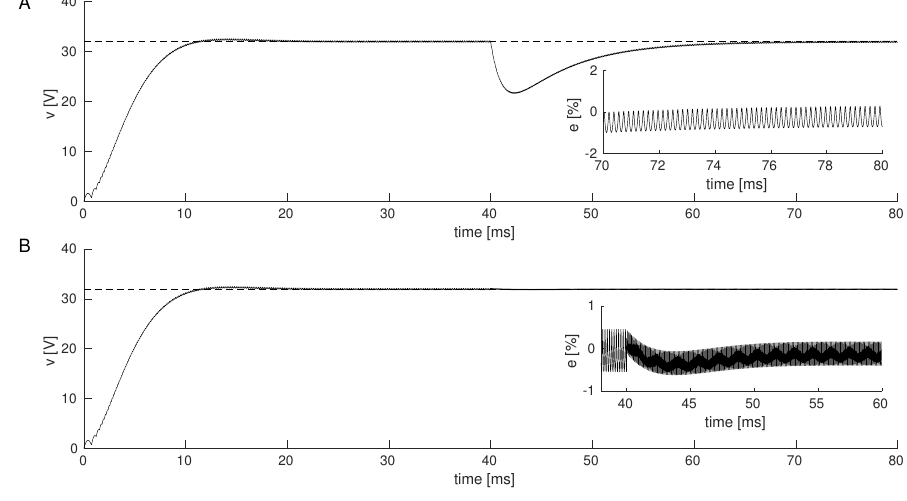
Figure 5. ( a ) Time response of the capacitor’s voltage v . During the first 40ms, the value of the resistor is set to R = 20 Ω , after this the load is changed to R = 15 Ω . Inset: Steady state percentage error (considered 25 ms after the presentation of the disturbance). The desired output is plot with the dashed line; ( b ) Same as ( A ) for a disturbance in the input voltage E . During the first 40 ms E = 40 V, after this it is changed to E = 50 V. In this panel, the inset shows the percentage error during the first 20 ms after the presentation of the input disturbance. Other details as in Figure